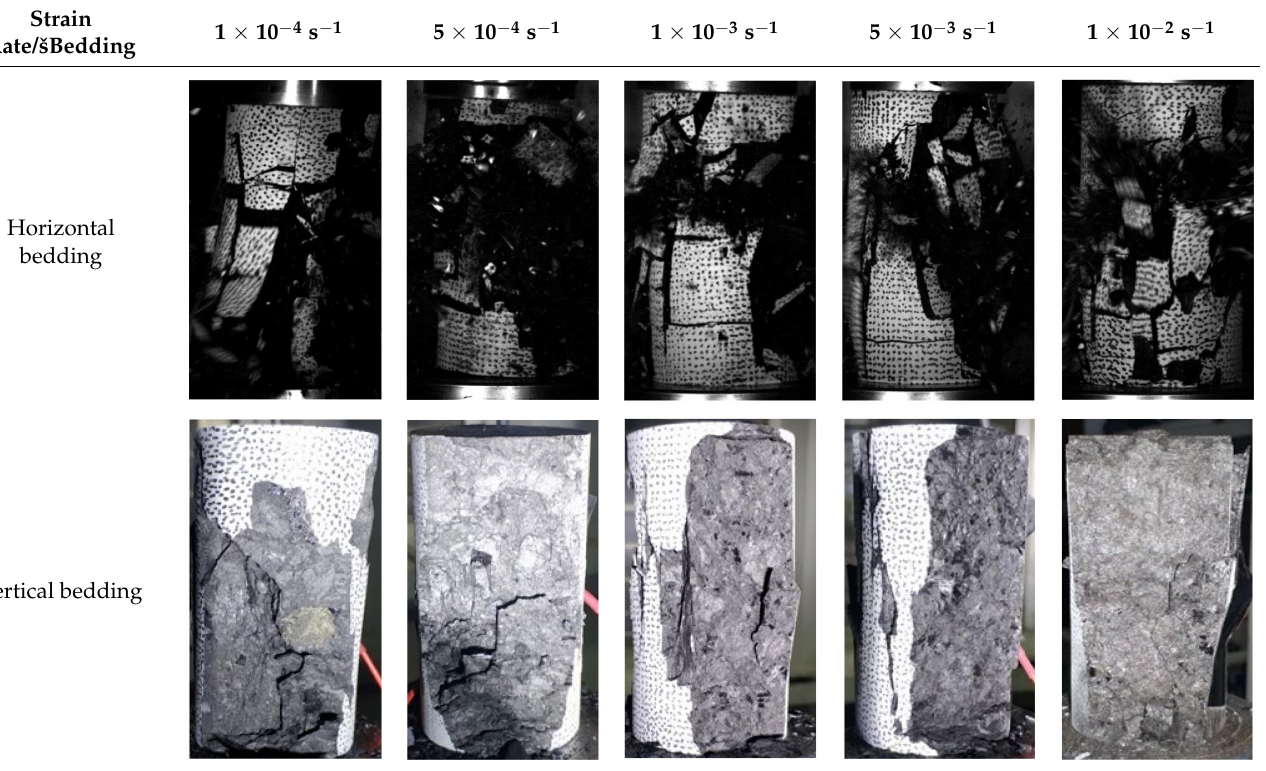
Table 2. Failure modes of coal